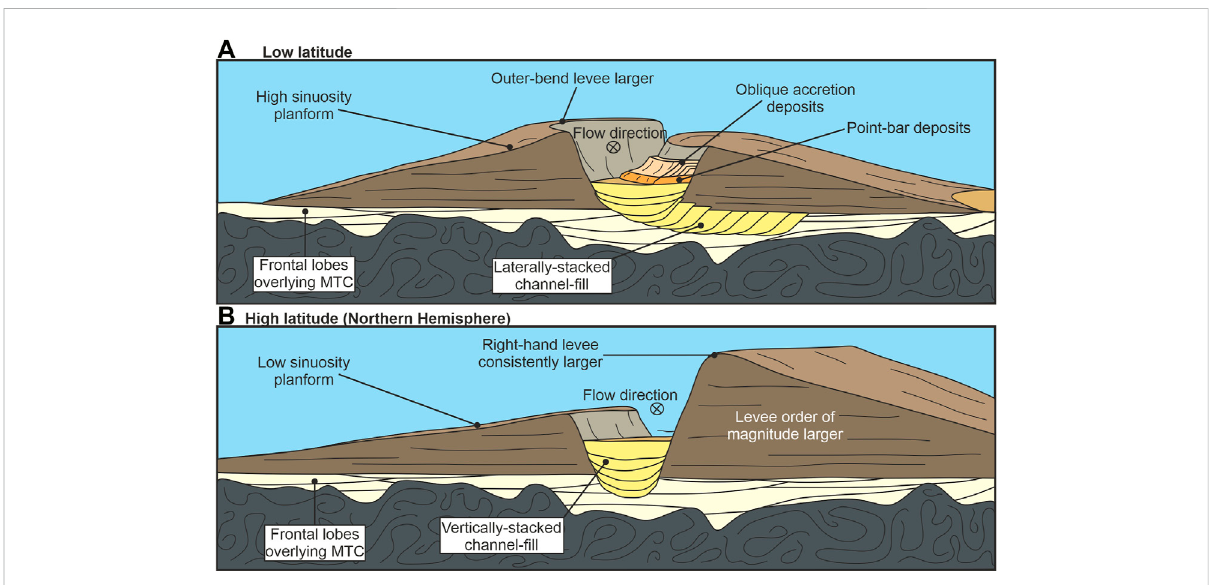
FIGURE 13 Schematic diagram of architectural differences between high and low latitude channel-levee systems. (A) Low latitude systems exhibit frontal lobes deposited over MTD deposits (Posamentier and Kolla, 2003), overlain by a channel-levee system with higher levees on outer bends, with symmetricalleveesonstraightersections, ‘ J-shaped ’ channel fi llgeometries(Jobeetal.,2016),inner-bankdepositionandahigh-sinuosityplanform. (B) High latitude channel levee systems are characterised by deposition of frontal lobe deposits over an MTD, followed by asymmetrical levees (right-hand levee higher in the Northern Hemisphere, left-hand levee higher in the Southern Hemisphere) that can be over an order of magnitude larger than low latitude systems), and vertical stacking of channel fi